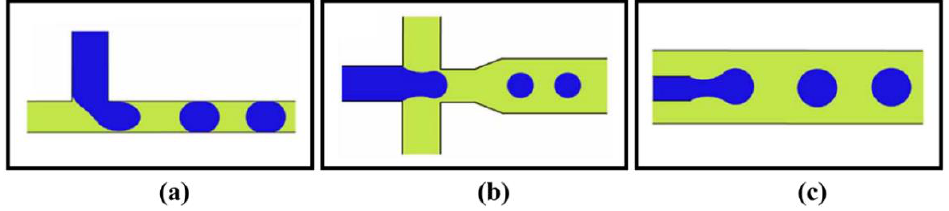
Figure 5. Schematic design of different droplet generation geometries: ( a ) Crossflow, ( b ) Flow-focusing, and ( c ) Co-flow; adopted with permission from [53], Copyright 2022, IOP Publishing Ltd.